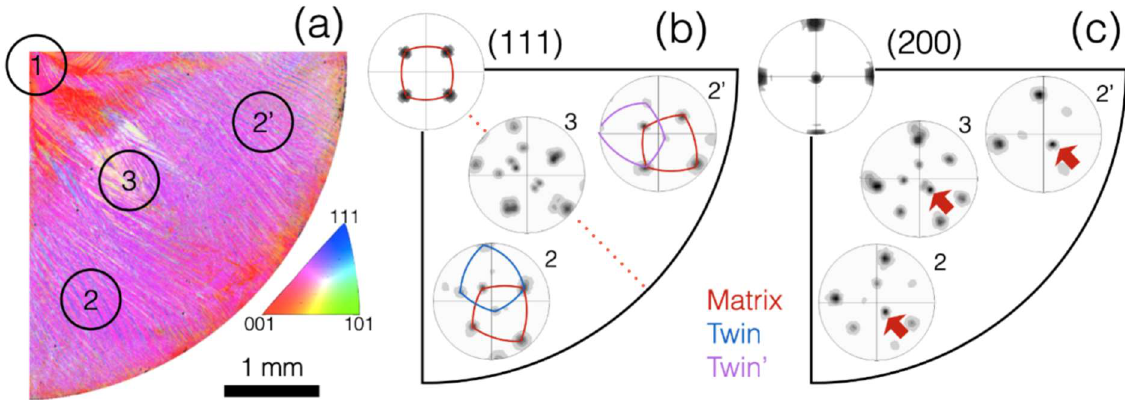
Figure 2. EBSD analysis of one crystal quadrant deformed to 0.68 of the true strain. IPF map showing 4 distinctive regions ( a ). Pole figures from the regions marked in IPF ( b , c ), corresponding to the (111) and (200) planes reconstruction, respectively. Red arrows show direction with respect to which matrix lattice rotates while red dotted line is showing additional symmetry in the formed microstructure.